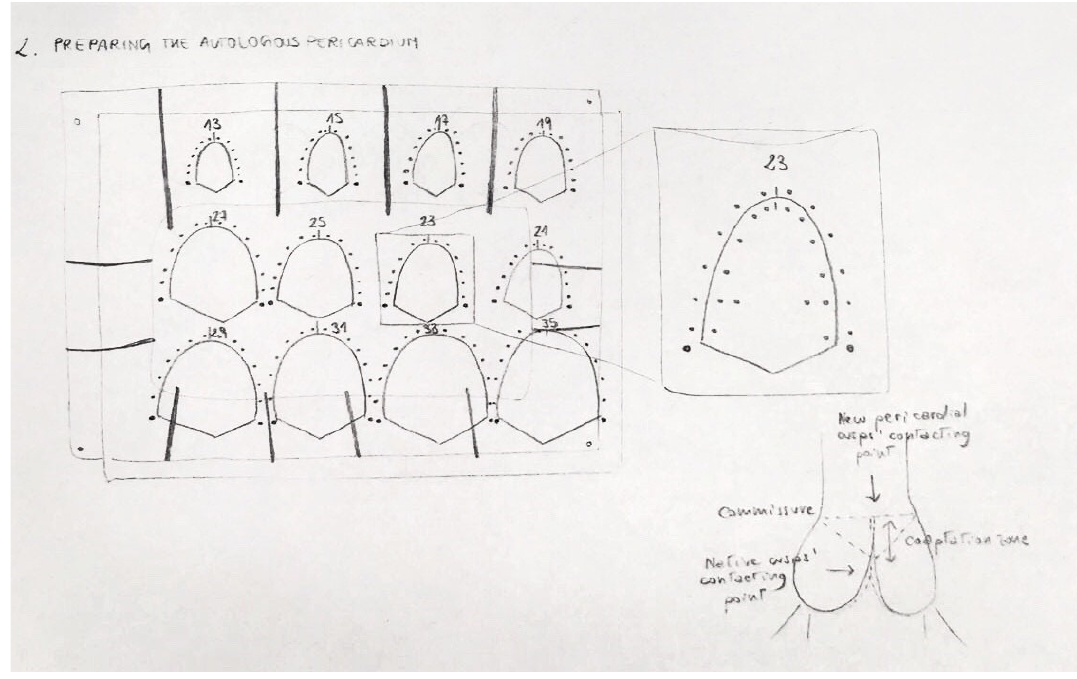
Fig. 1 - Dedicated Ozaki sizer. AM=anterior mitral leaflet; AS=atrial side; LA=left atrium; LCC=left coronary cusp; NCC=non-coronary cusp; RA=right atrium; RCC=right coronary cusp; STJ=sinotubular junction; VS=ventricular